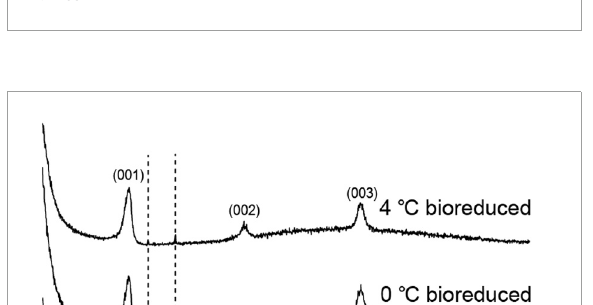
FIGURE2 Production of total dissolved Fe from IMt-1 during batch experiment at various temperatures (0 and 4 ◦ C) and incubation times.